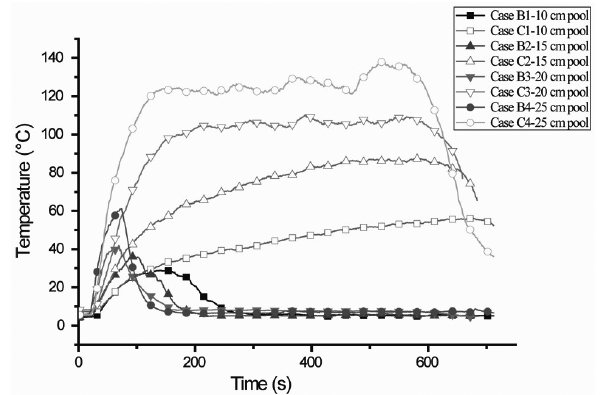
Fig. 8. Temperature of thermocouple T3 ( height 0.6 m, Door 3 left 5 cm) in case B1-B4 ( Top Vent: Open) and case C1-C4 (Top Vent: